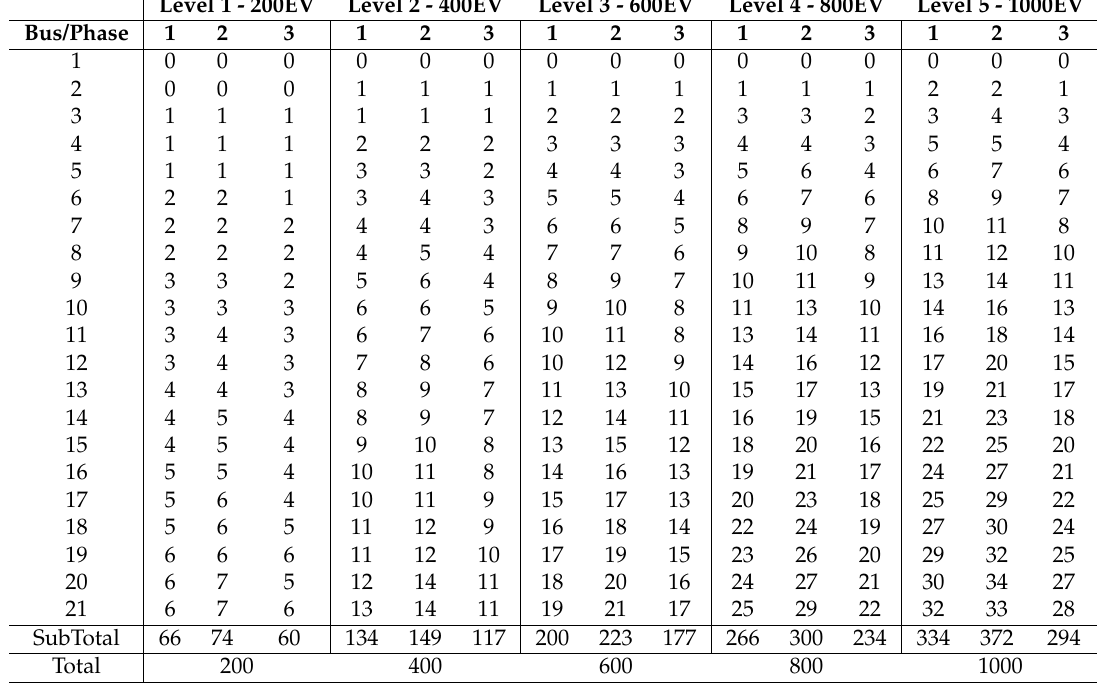
Table A1. EV units connected per bus and per phase at each EV penetration